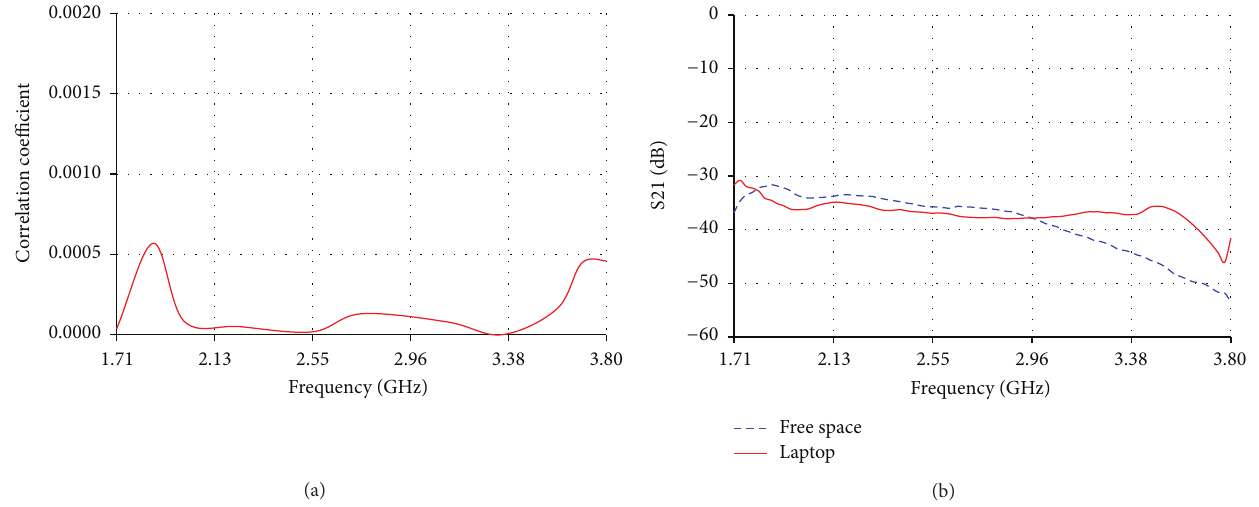
Figure 15: (a) Correlation coefficient and (b) measured isolation between primary and diversity MIMO high band antennas perpendicular to each other and 10cm